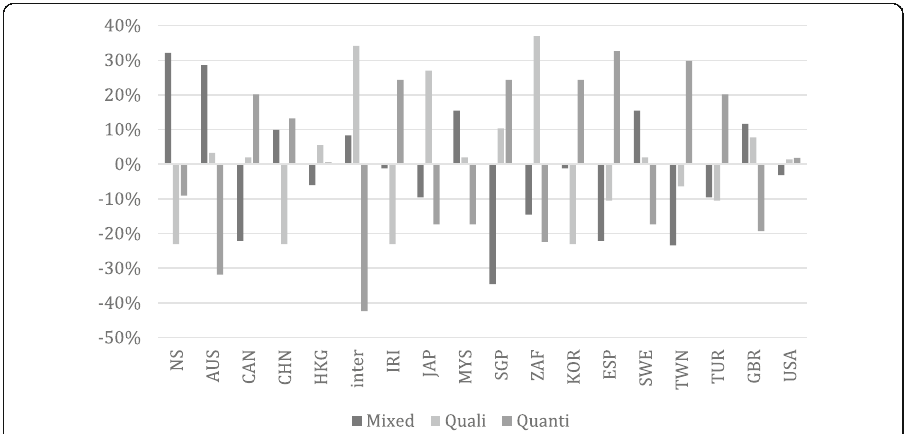
Fig. 3 Percentage deviation from the average relative frequencies of the different data collection formats per country ( ≥ 3 articles). Note. NS = not stated; AUS = Australia; CAN = Canada; CHN = China; HKG = Hong Kong; inter = international; IRI = Iran; JAP = Japan; MYS = Malaysia; SGP = Singapore; ZAF = South Africa; KOR = South Korea; ESP = Spain; SWE = Sweden; TWN = Taiwan; TUR = Turkey; GBR = United Kingdom; USA = United States of